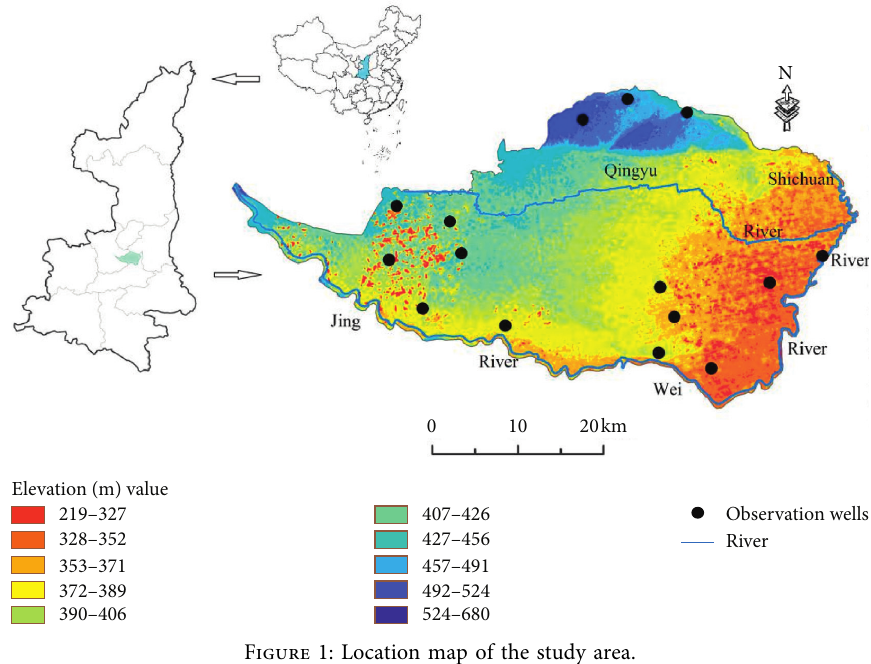
Figure 1: Location map of the study area.